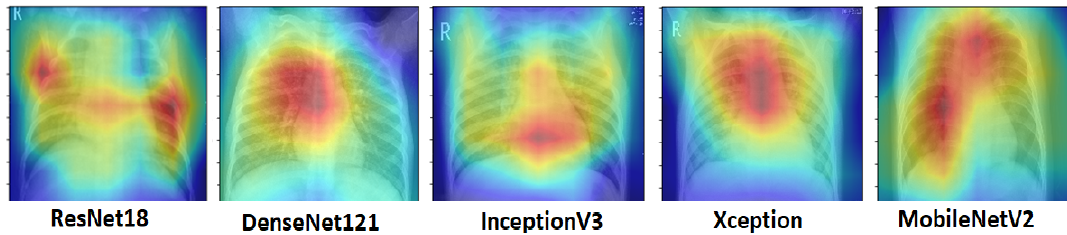
Figure 12. Activation maps for chest X-rays having viral pneumonia corresponding to different architectures. Viral pneumonia, with a more diffused “interstitial” pattern in both lungs, was detected by the deep learning